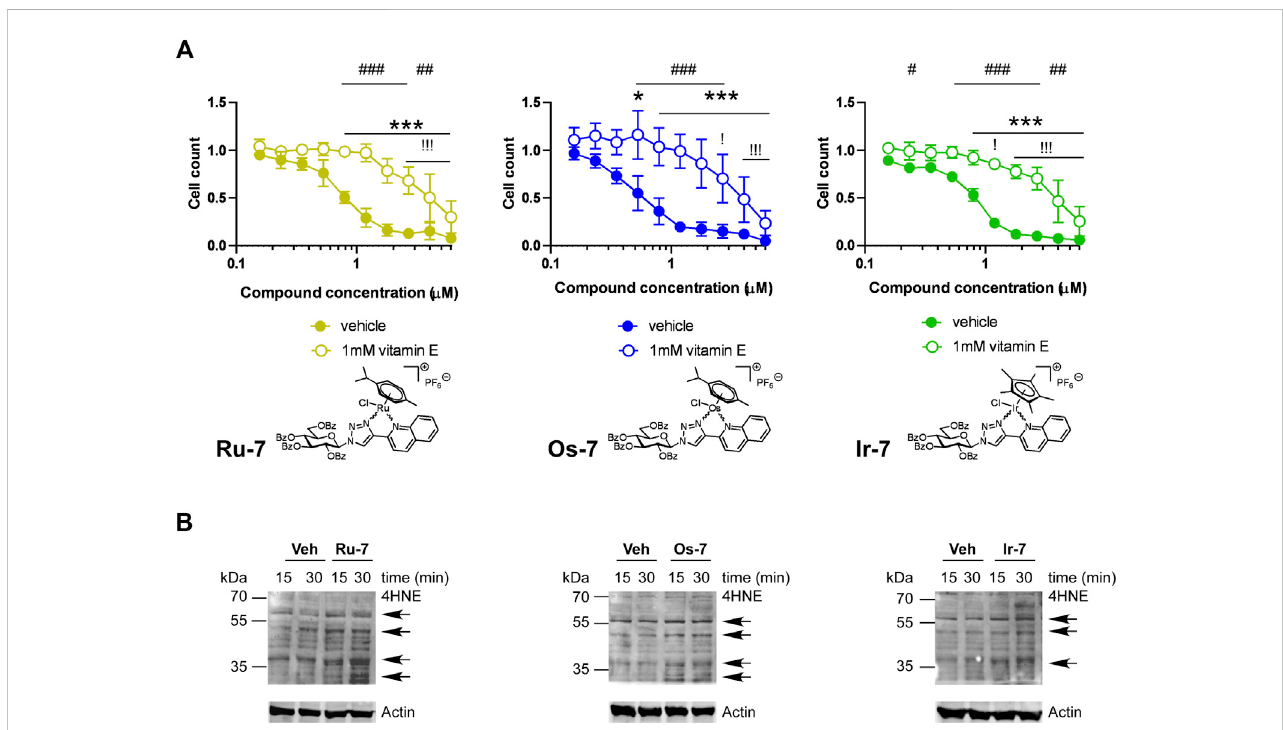
FIGURE 9 (A) VitaminE, alipid soluble antioxidantblocksthecytostatic activityofthebioactivecomplexes.1.5×10 3 A2780 cellswereplated to96wellplates.Cells weretreatedwiththecompoundsintheconcentrationsindicatedfor48 hfollowedbyanSRBassay.Dataisrepresentedasaverage±SD,fromfourbiological replicates; individual assays were performed in duplicates. Values were normalized for vehicle treated cells, absorbance for vehicle treated cells equals to 1. Normality was checked using the D ’ Agostino-Pearson normality test. The Ru-7 and the Os-7 dataset showed normal distribution, while the Ir-7 dataset was normalized using the Box-Cox normalization method. Statistical signi fi cance was assessed using two-way ANOVA test comparing all measurement points. *and ***representstatisticalsigni fi cance at p < 0.05 and0.001,respectively, between thelowestconcentrationand thehigherconcentrationsamong non-vitamin E-treated cells. ! and !!! represent statistical signi fi cance at p < 0.05 and 0.001, respectively, between the lowest concentration and the higher concentrationsamongvitaminE-treated cells. #, ##and ### represent statistical signi fi cance at p < 0.05, p < 0.01 and 0.001, respectively, between thenon- vitamin E-treated vs. vitamin E-treated cells. (B) A2780 cells were treated with the indicated complexes ( Ru-7 at 0.846 μ M, Os-7 at 0.578 µM and Ir-7 at 0.891 µM) for the time indicated. Cells were harvested and lysed. Cellular proteins were separated on a 10% SDS-PAGE gel and were blotted. Blots were probed with the antibodies indicated (top blot with 4HNE antibody, lower blot with actin antibody). Arrows point at band of interest. Experiments were repeated three times and a representative blot is shown. On the blots brightness and contrast were